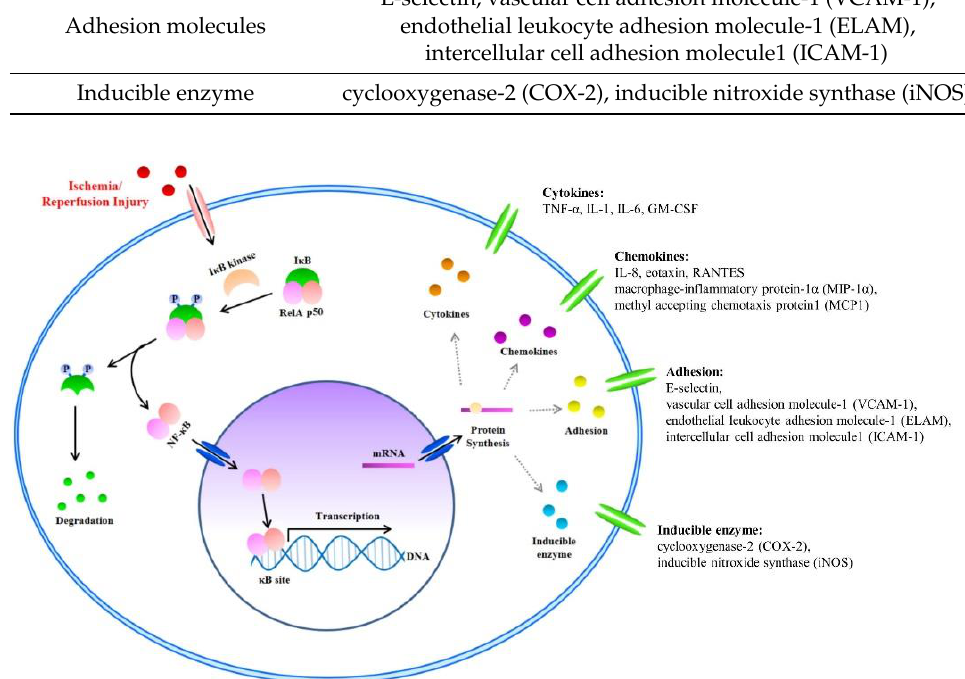
Figure 2. The nuclear factor kappa B (NF- κB) signal and Inflammatory Factors in I/R injury. I/R injury factors enter the cytoplasm. Activated inhibitor of kappa B (IκB) kinase separates the NF - κB/IκB complex into NF - κB and IκB. Separated IκB is degraded in the cytoplasm, and the NF - κB dimer (RelA/p50) translocates to the nucleus. Within the nucleus, the NF- κB dimer (RelA/p50) binds